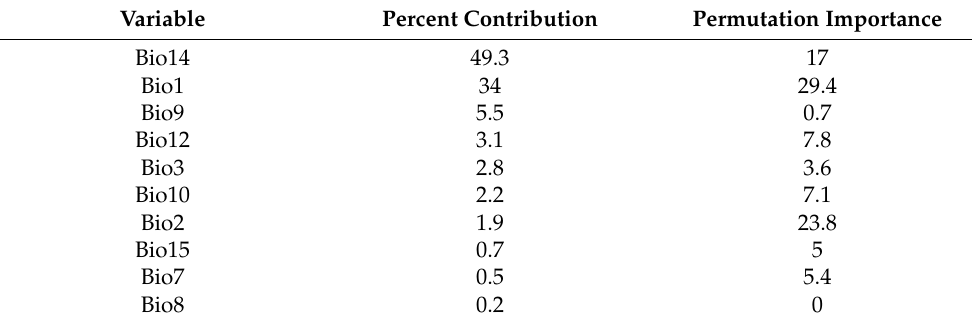
Table 2 . Variable contribution for ASFV distribution . Table 2. Variable contribution for ASFV distribution.